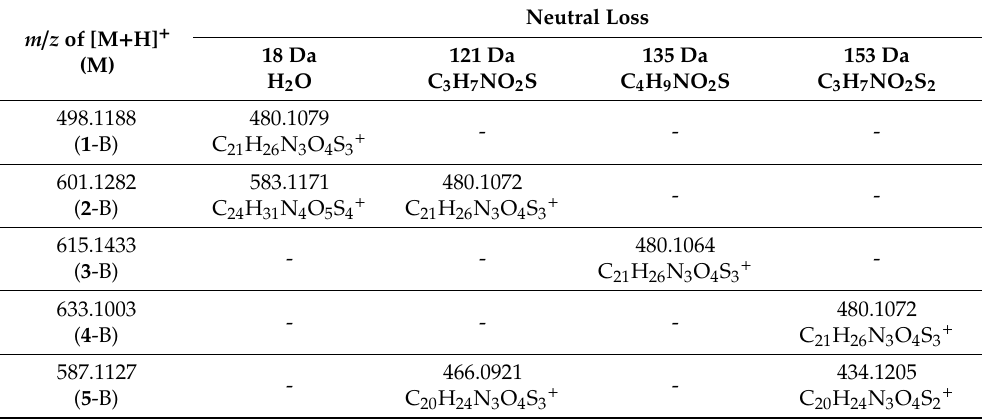
Table 11. Selected NLs recorded during MS 2 experiments for the B isomers of the novel derivatives of Ybt by application of LC-MS / HRMS. All recorded fragmentation spectra are shown in the Supplementary Material. The resulting fragments [M-X + H] + caused by the specific NL [X] listed on top of the columns are noted in the table.